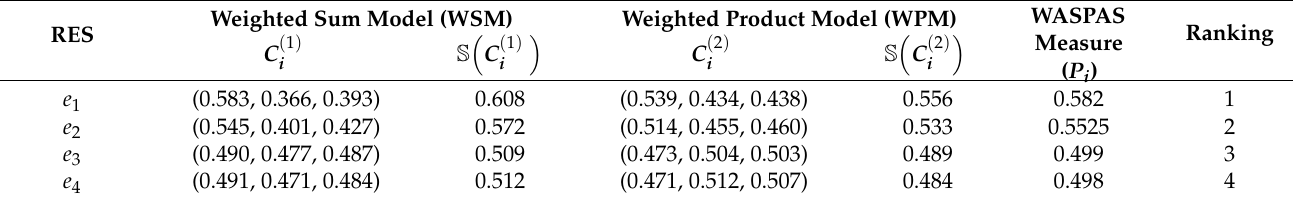
Table 14. Computed results of SVN-WASPAS